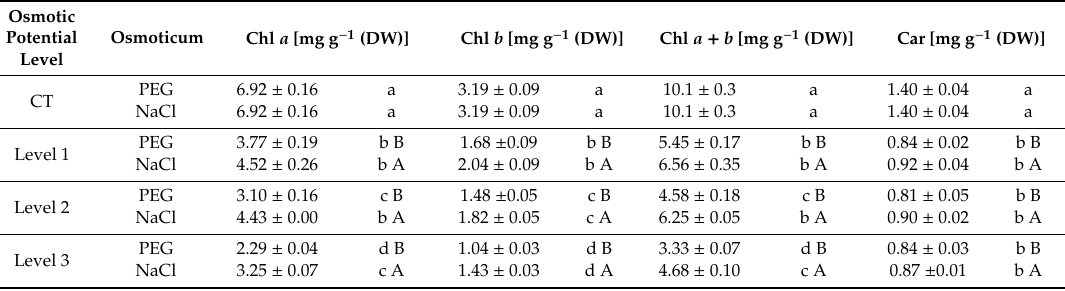
Table 1. Means ± SD of chlorophyll (Chl a , Chl b , total Chl) and carotenoids (Car) in leaves collected from seedlings growing under three iso-osmotic potential levels under separate PEG and NaCl